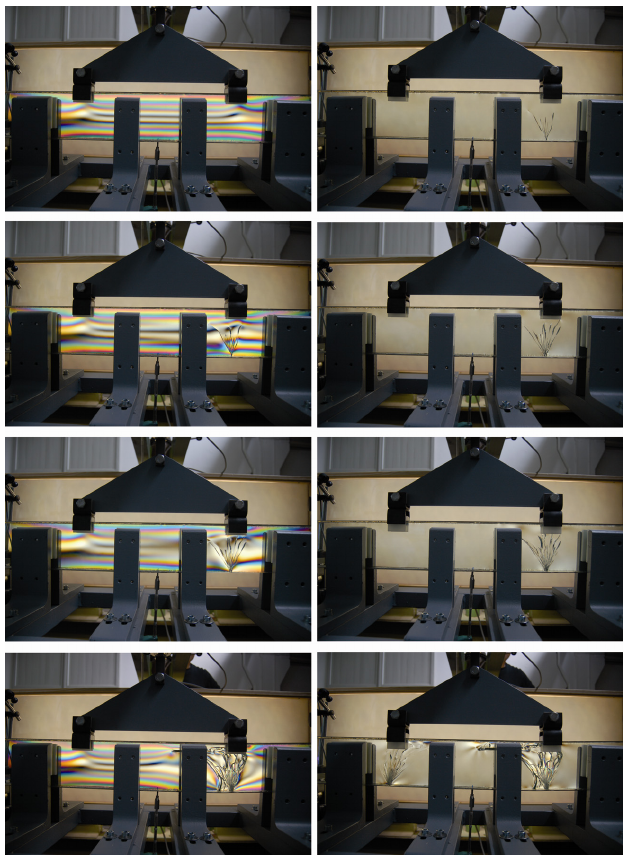
Figure 3: Changes of stress during